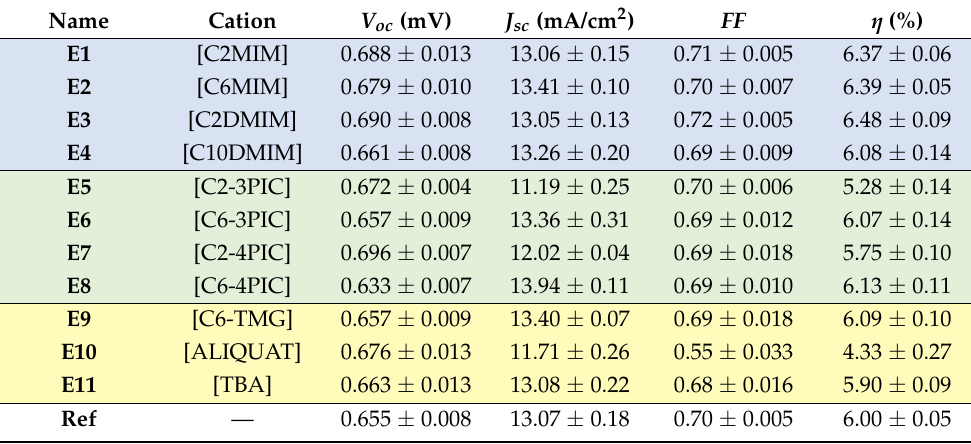
Table 3. Performance values of the test cells employing the various iodide-based organic salts as additives in combination with 4-TBP under 100 mW cm − 2 AM 1.5G illumination. The results correspond to the average of five measurements of two cells per electrolyte